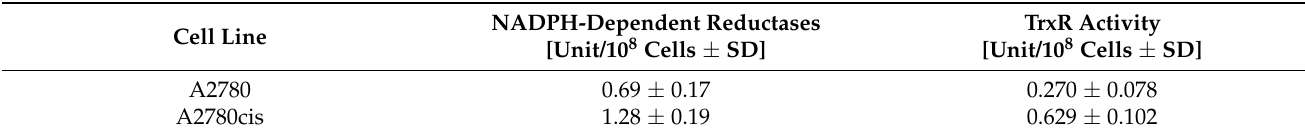
Table 3. Basal thioredoxin reductase activity in A2780 and A2780cis cells. The results are expressed as means ± SD ( n = 3). Cell